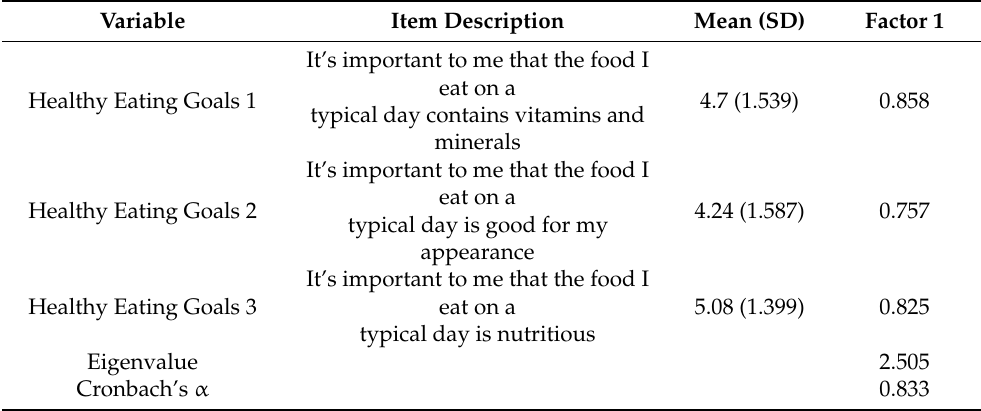
Table 1. Healthy Eating